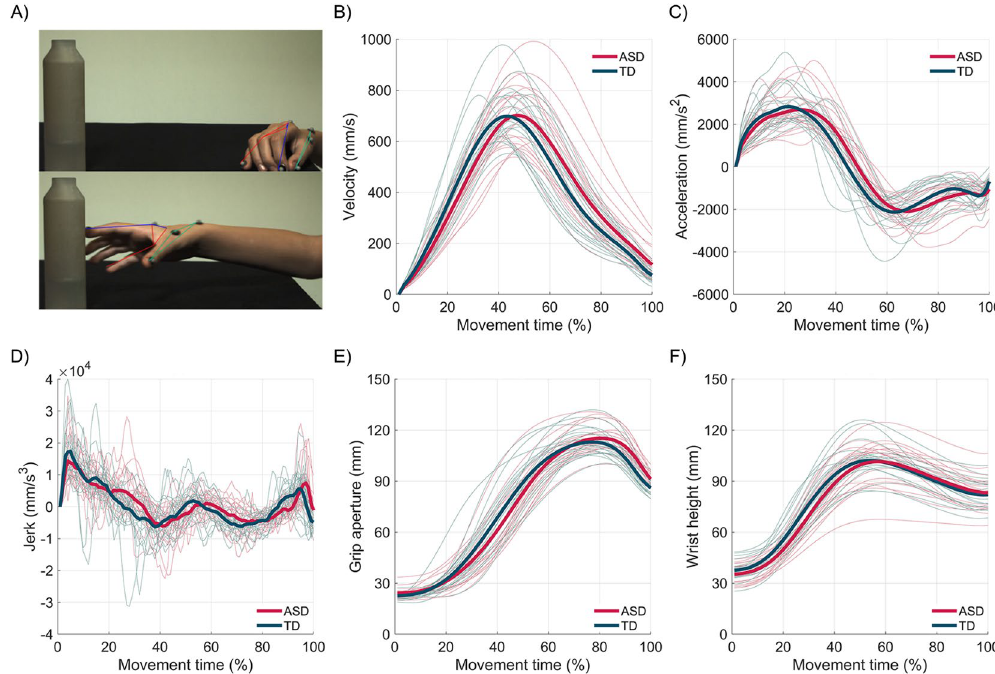
Figure 1. ( A ) Image sequence of a reach-to-grasp movement with hand model overlay. ( B–F ) Kinematic profiles of reach-to-grasp movements performed with three prospective intentions (to place, to pour, to pass). Wrist velocity ( B ), wrist acceleration ( C ), wrist jerk ( D ), grip aperture ( E ) and wrist height ( F ) were extracted. Thick lines represent group average (red = ASD group, green = TD group). Thin lines represent trial-average of individual